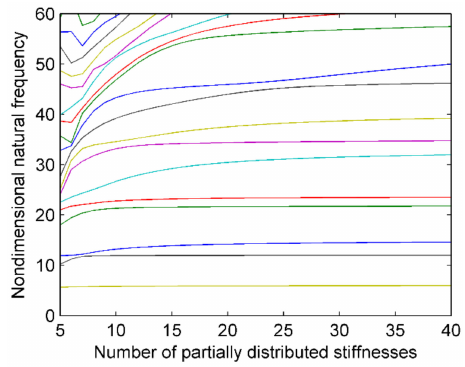
Figure 6. Natural frequencies of a planet ring with the different number of partially distributed stiffnesses at ω =